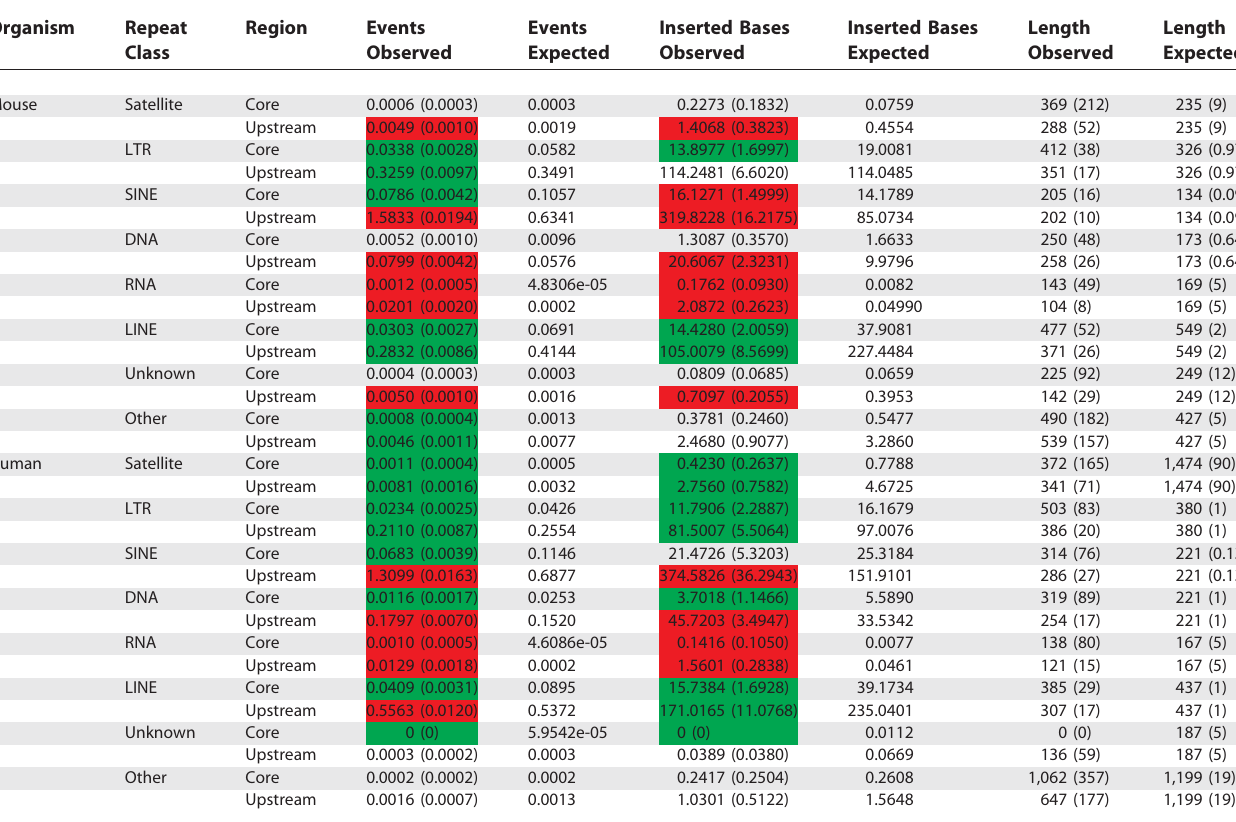
Table 3. Repeat Densities in Mouse and Human Promoter Regions